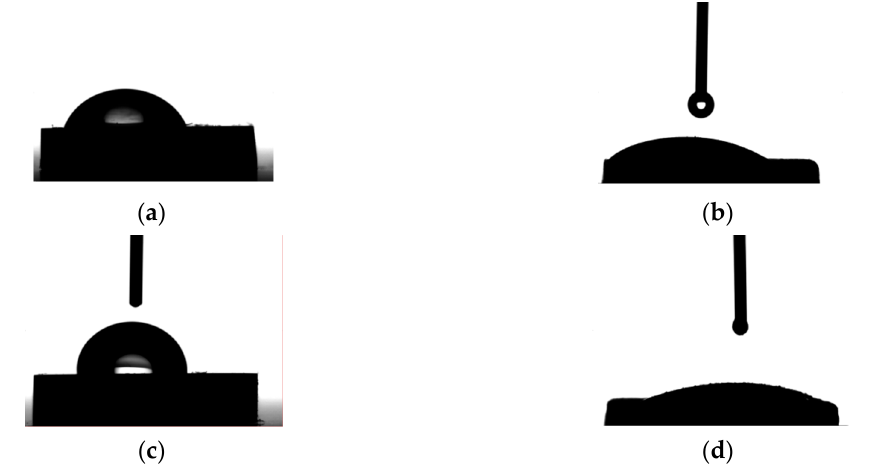
Figure 22. Photograph of water contact with Mg alloy surfaces: ( a ) ZM21; ( b ) ZM21-HAP; ( c ) ZMX410; ( d ) ZMX410-HAP.